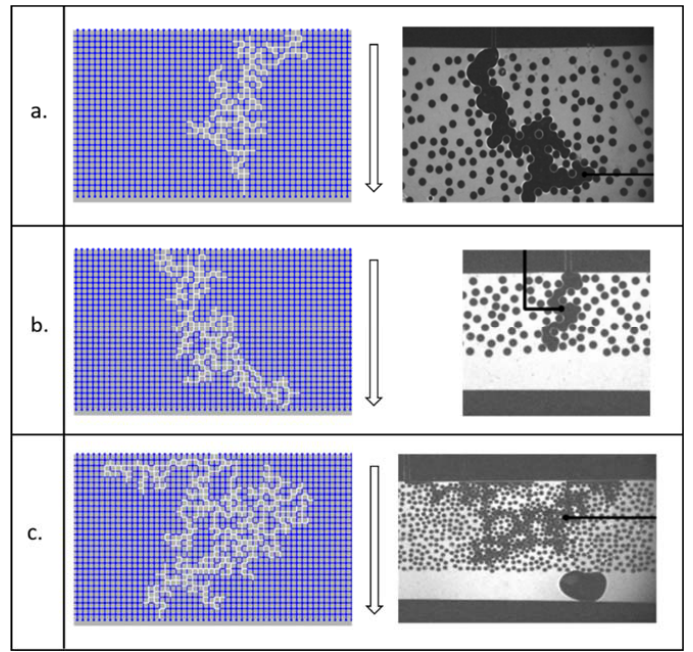
Figure 14. PSDs used for different PTL types with standard deviations: 1.0 μ m for foam, 1.7 μ m for felt and 2.5 μ m for sintered.